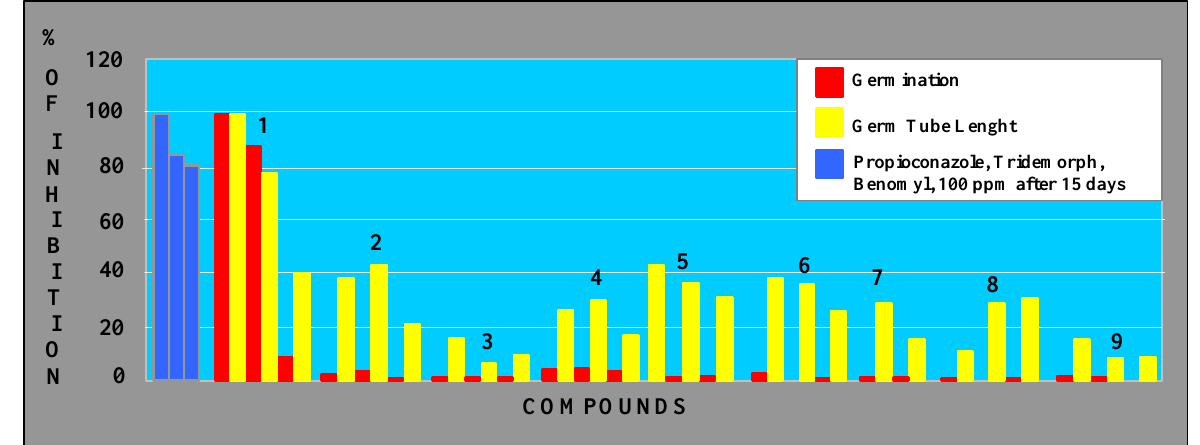
Figure 3. The other compounds, including the phytoalexins, displayed only moderate effects.